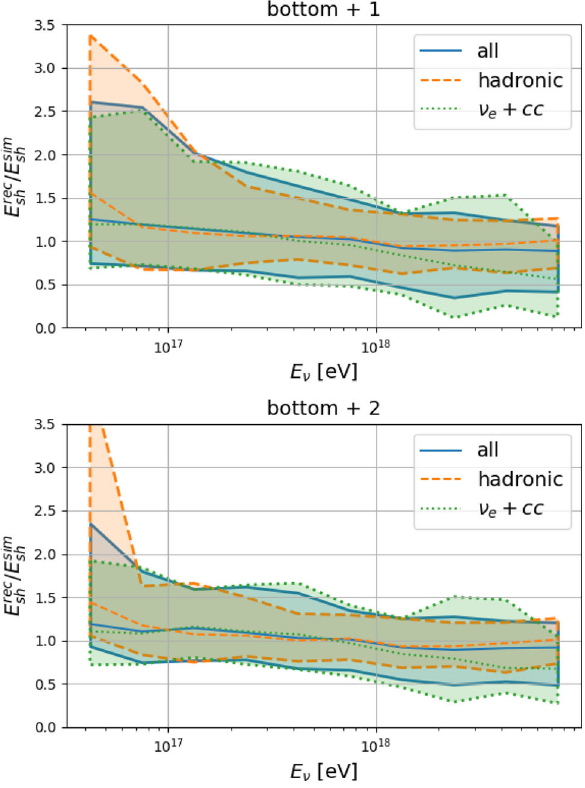
Fig. 15 Median and 68% quantiles of the ratios between reconstructed and actual shower energies as function of neutrino energy. The results are shown for events that only produced a hadronic showers, as well as for charged-current interactions of electron neutrinos. The top panel shows events where at least one of the channels at ∼ 100 m detected a pulse with SNR ≥ 2 . 5 as well as at least one of the other channels on the power string , the bottom panel shows results with at least two additional channels on the power